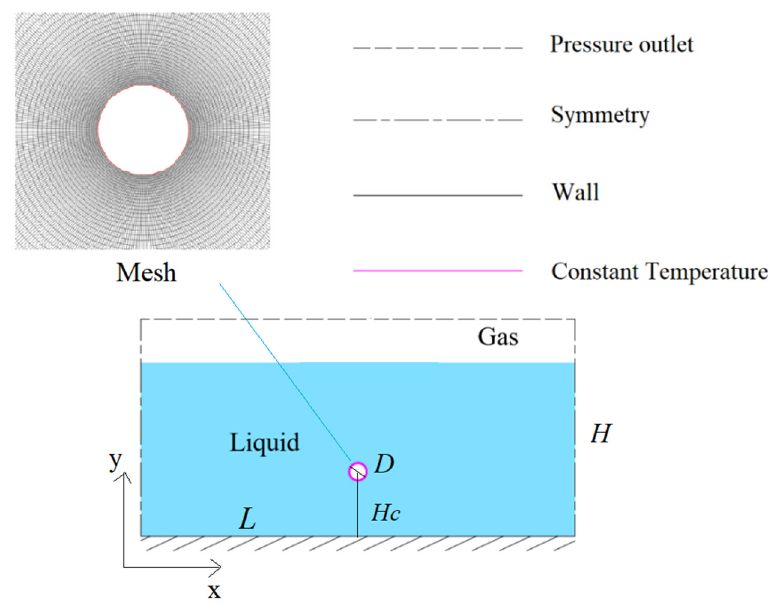
Figure 2. The geometric diagram and boundary conditions (Adapted from Ref. Figure 2. The g eometric diagram and boundary conditions (Adapted from Ref. [2]).